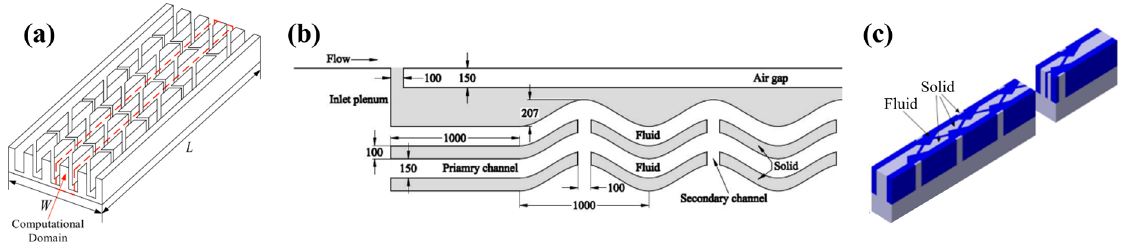
Figure 10. MCHS with secondary channels: ( a ) trapezoidal fins [115]; ( b ) wavy microchannel [117]; ( c ) microchannel with cavities and ribs [118].